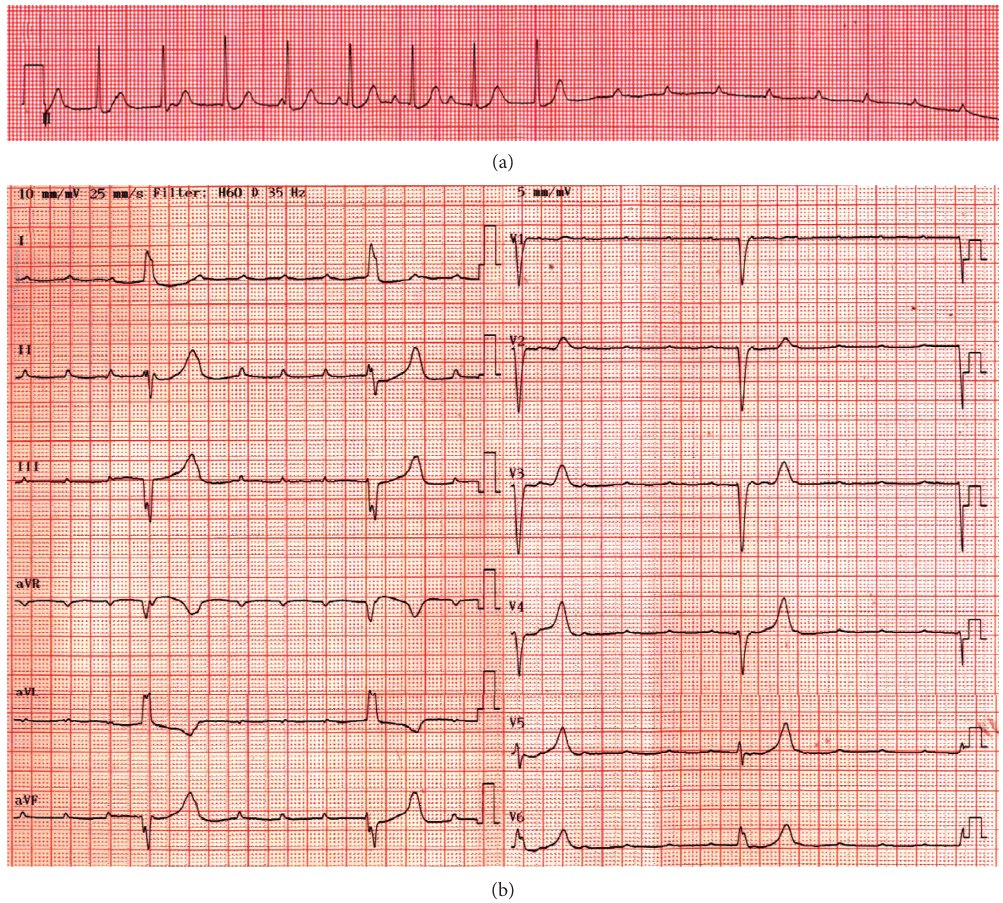
Figure 1: (a) Electrocardiography performed at the primary care clinic showing complete atrioventricular block with supraventricular rhythm, followed by long ventricular asystole over 4.4 seconds. (b) Follow-up electrocardiography at the emergency room revealing complete AV block with ventricular escape rhythm.